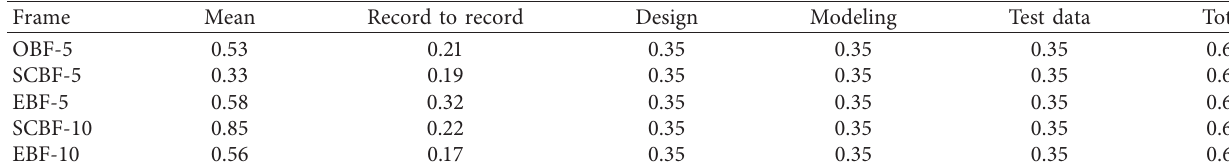
Table 10: Uncertainty parameters and their combination results.